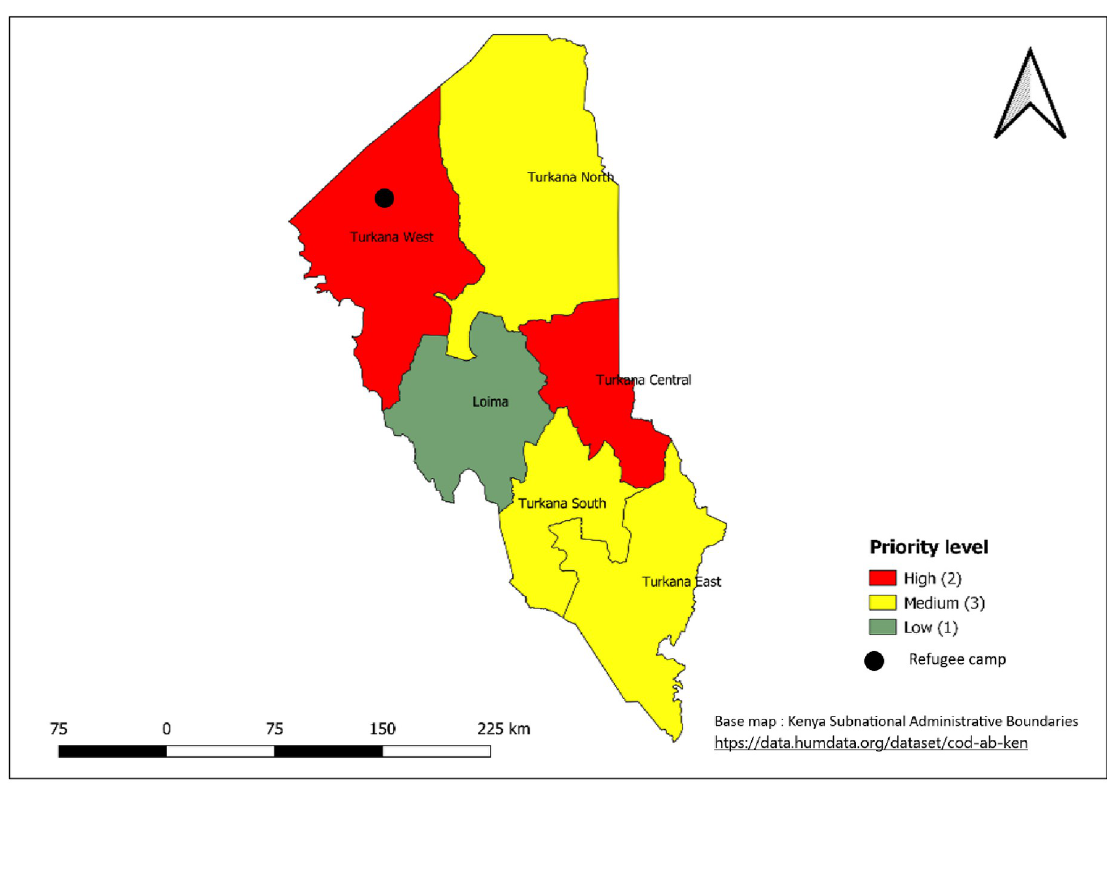
Fig 9. Priority sub-counties in Turkana County based on a combination of Epidemiological and WASH indicators, 2015–2019. Link to base map layer: https://data.humdata.org/dataset/cod-ab-ken Link to terms of use: https://data.humdata.org/faqs/licenses.